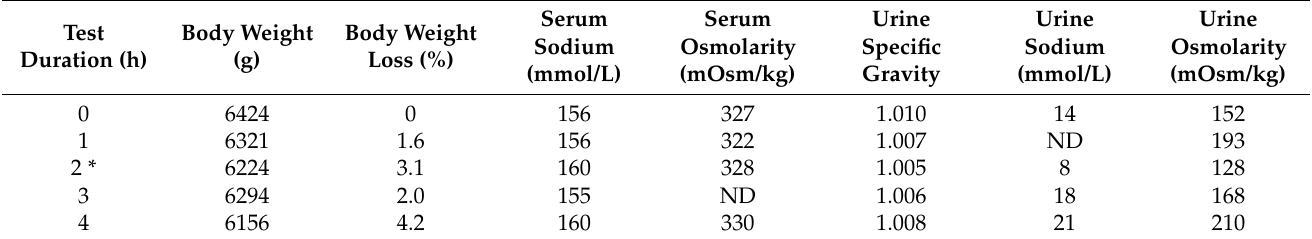
Table 1. Results of the water deprivation and desmopressin challenge tests.